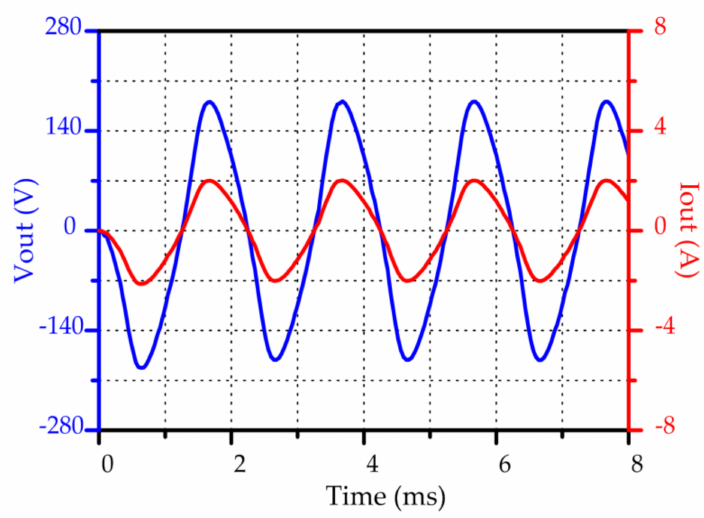
Figure 13. Output waveforms with 90 Ω resistance and at 2500 r/min.